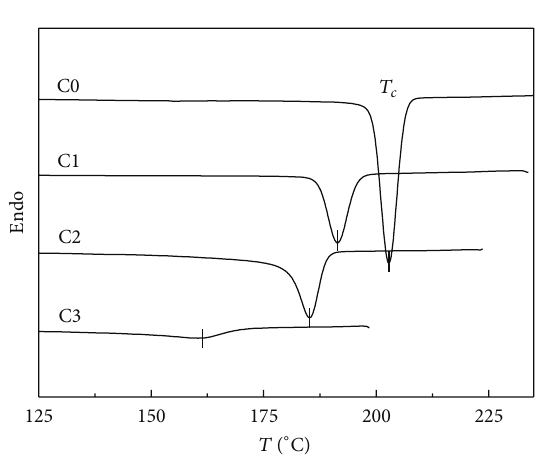
Figure 3: Glass transitions of the various copolymers.